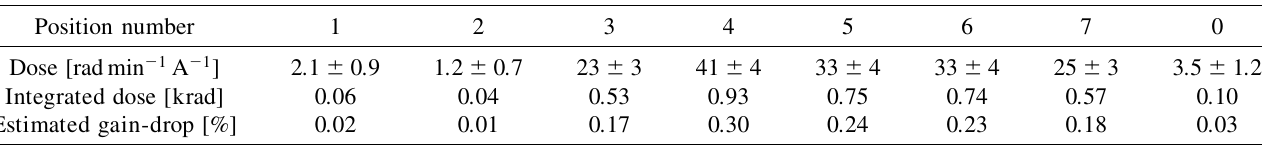
position numbers correspond to the azimuthal coordinate with respect to the beam axis, and the numbers 2, 4, 6, 0 indicate the top,